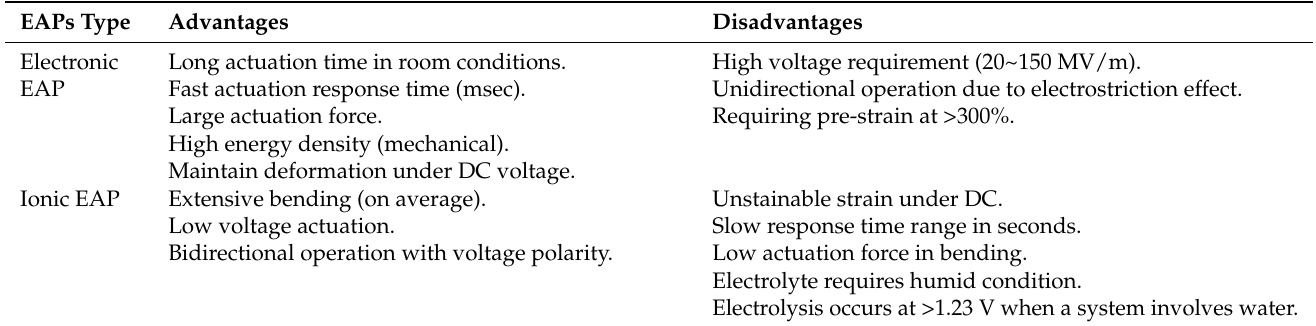
Figure 2. A Visualization of deformation during activation of ( a ) dielectric EAP and ( b ) ionic EAP. Adapted from Engel et al. [6]. Table 1. Characteristics comparison of ionic and electronic EAP. Adapted from Engel et al. [6] and Bar-Cohen et al.